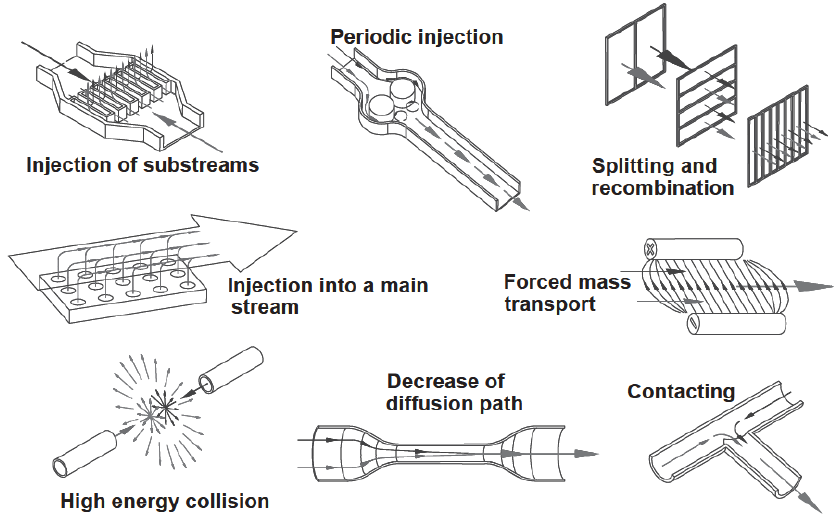
Figure 1. Selective passive and active micromixer principles [Reprinted from [64]. Copyright (2005) with permission from Elsevier].